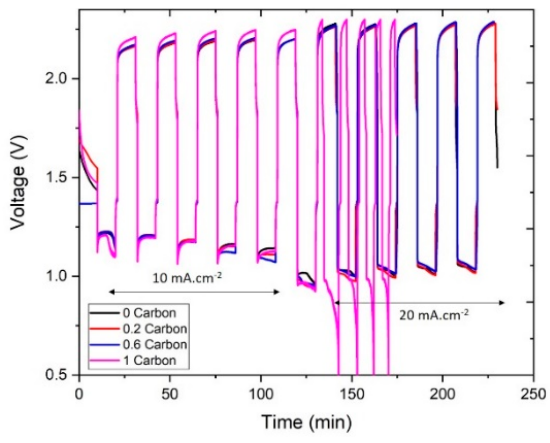
Figure 6. Charge-discharge curves of the different slurries.